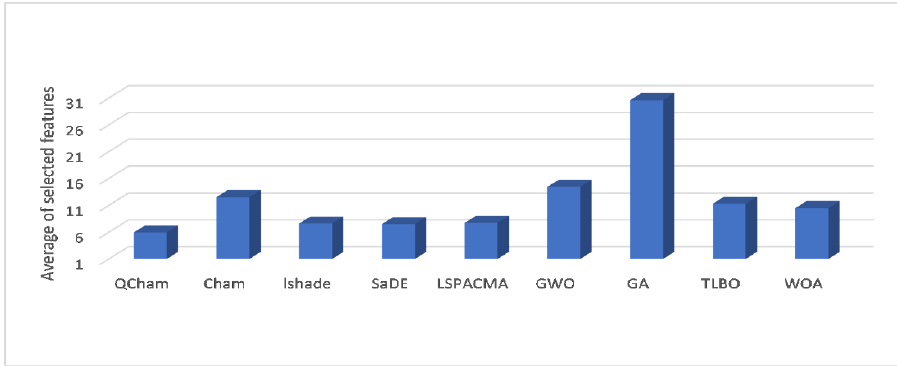
Figure 3. Average of selected features using QCham.